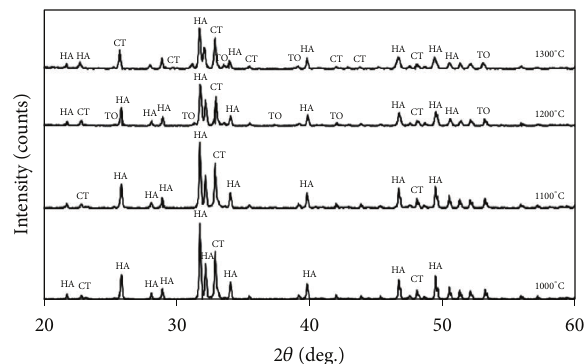
Figure 2: X-ray diffractograms of 5BHA composites sintered at different temperatures.